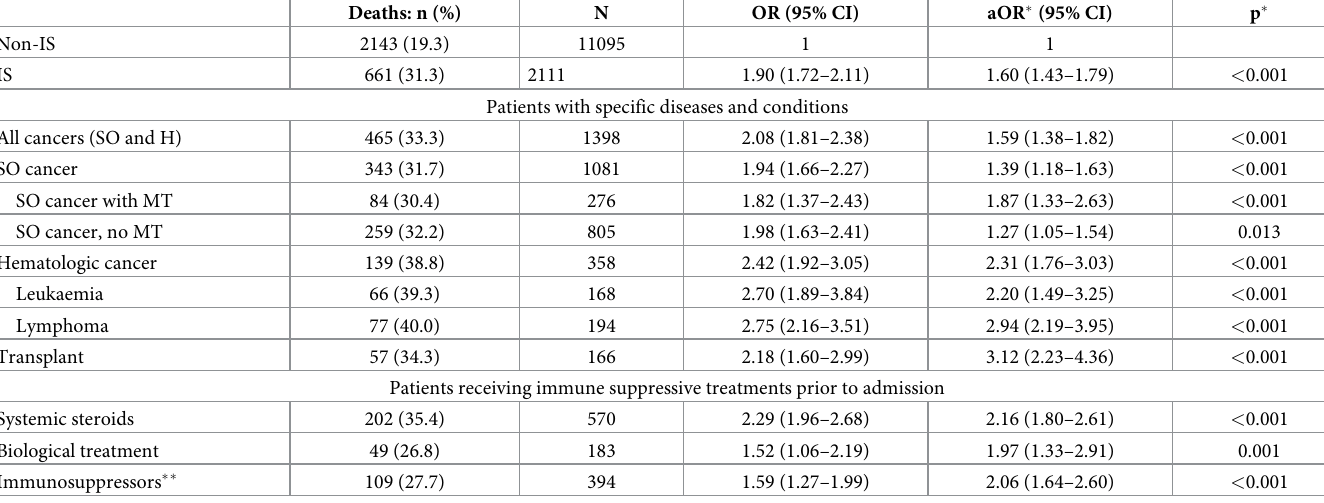
Table 3. Number of deaths (%), total number of patients, and crude and adjusted OR for death among immunosuppressed patients, patients with specific diseases or conditions (cancer [solid organ or haematologic], solid organ transplant or systemic autoimmune diseases), and patients receiving immune suppressive treat- ments prior to admission (systemic steroids, biological treatments, or immunosuppressors). All analyses have use non-immunosuppressed patients as reference category.